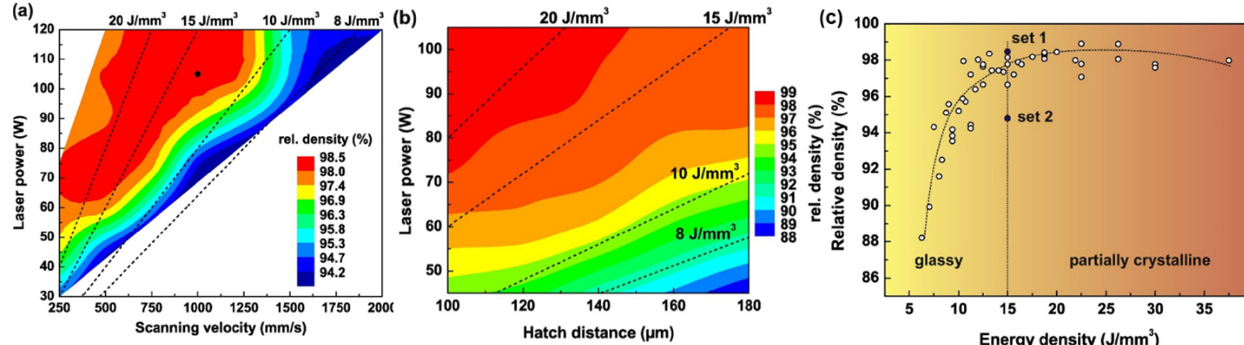
Figure 19. ( a ) Contour map of relative density of a Zr-based BMG fabricated via LPBF as a function of P and v , ( b ) contour map of relative density as a function of P and h , and ( c ) relative density as a function of VED. Modified from [33], with permission from Elsevier, 2021.